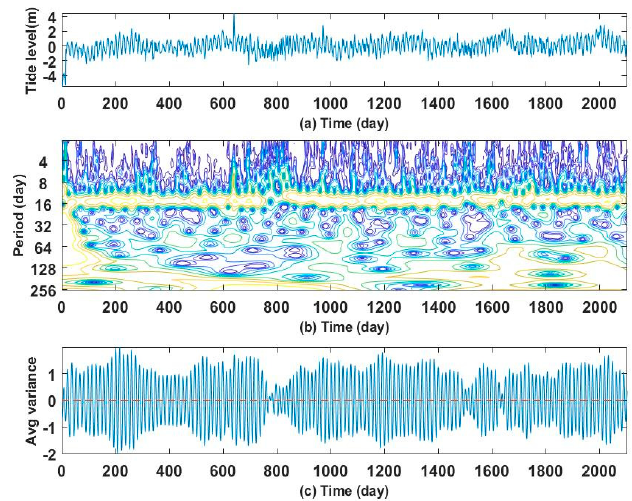
Figure 6. Wavelet analysis of daily data: ( a ) Ulsan tide level time series, ( b ) Power spectrum of Ulsan tide level, ( c ) 13–17 day scale-average time series. 13–17 days component was extracted because only these components satisfy the 95% confidence level.